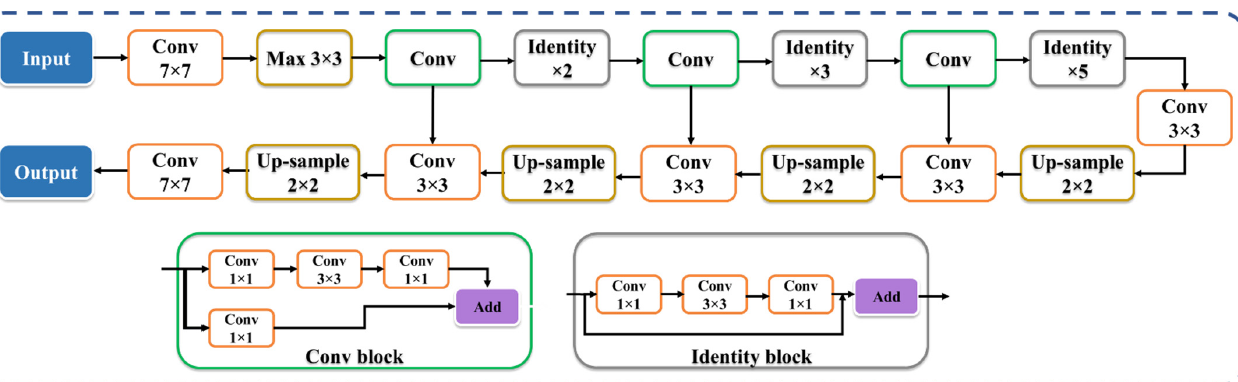
Figure 9. ResNet ‐ UNet’s architecture. Figure 9. ResNet-UNet’s